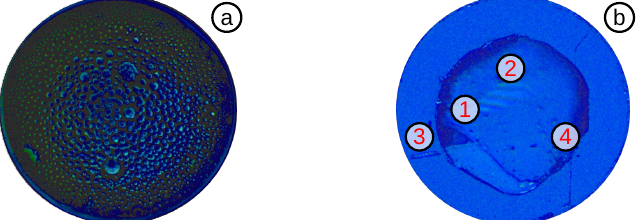
( a ) Glass particles inside of the cavity; ( b ) broken diaphragm caused by over-polishing with: (1) a hole; (2) glass inside of the cavity; (3,4) deep